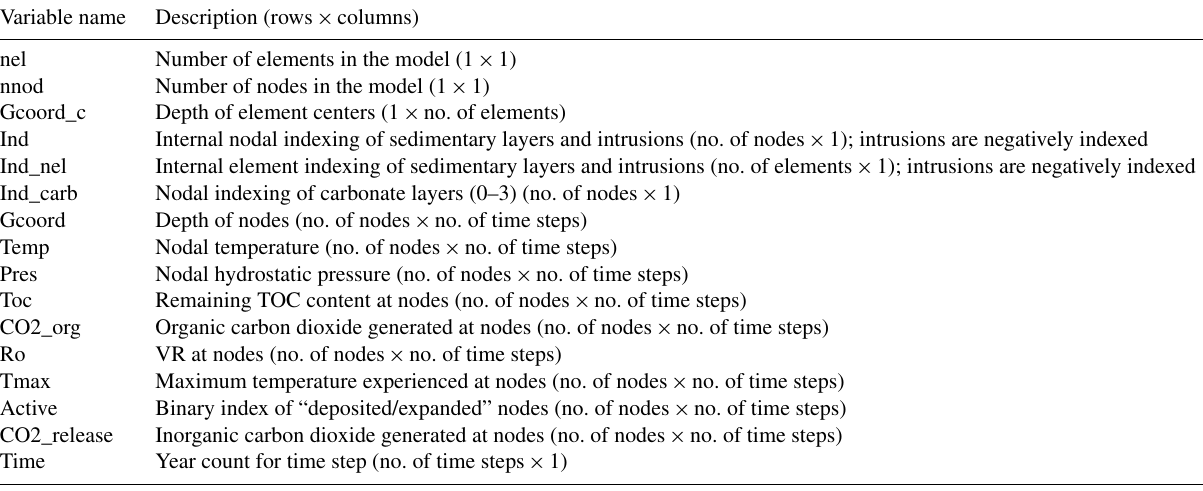
Table 5. List of variables in the “result” struct variable of the output file.